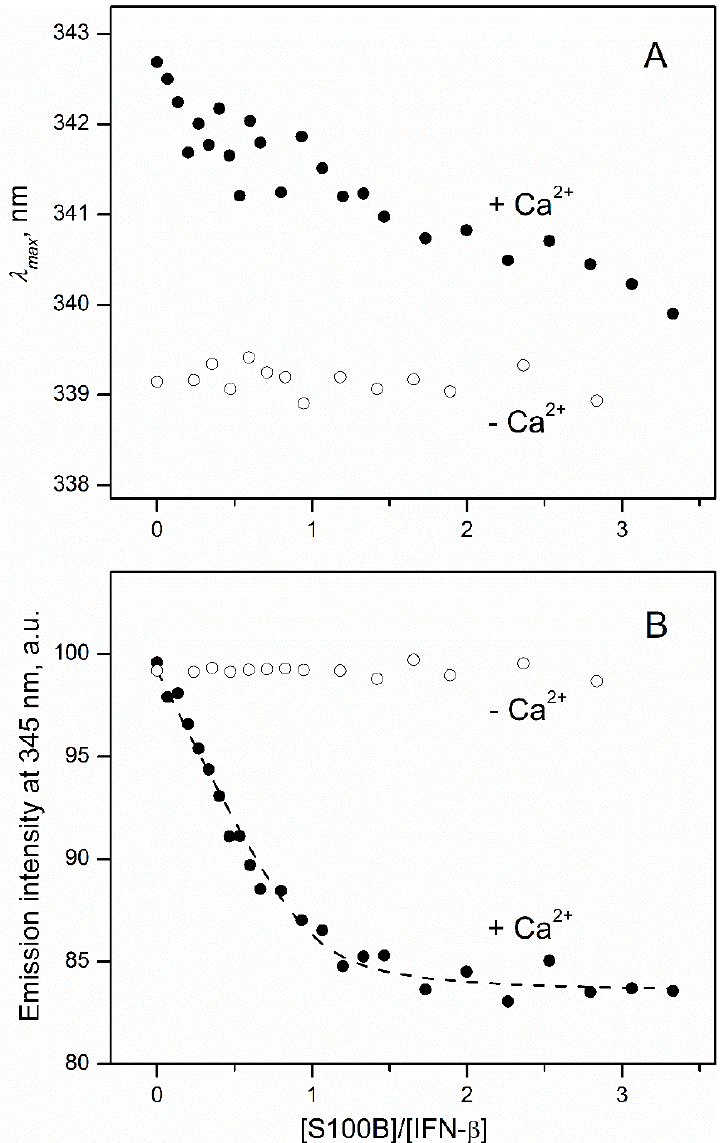
Figure 3. IFN- β interaction with S100B at 25 °C (1 mM CaCl 2 or 5 mM EDTA, pH 7.4), monitored by tryptophan fluorescence of IFN- β (0.5 µ M; excitation at 295 nm). ( A ) Spectrum maximum position; ( B ) emission intensity at 345 nm. The points are experimental, while the dashed curve is theoretical, fitted according to the one-site binding model.